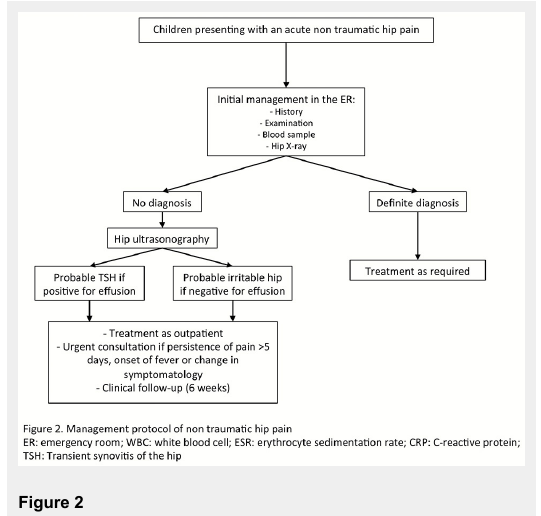
Management protocol of nontraumatic hip pain. ER = emergency room; TSH = transient synovitis of the hip